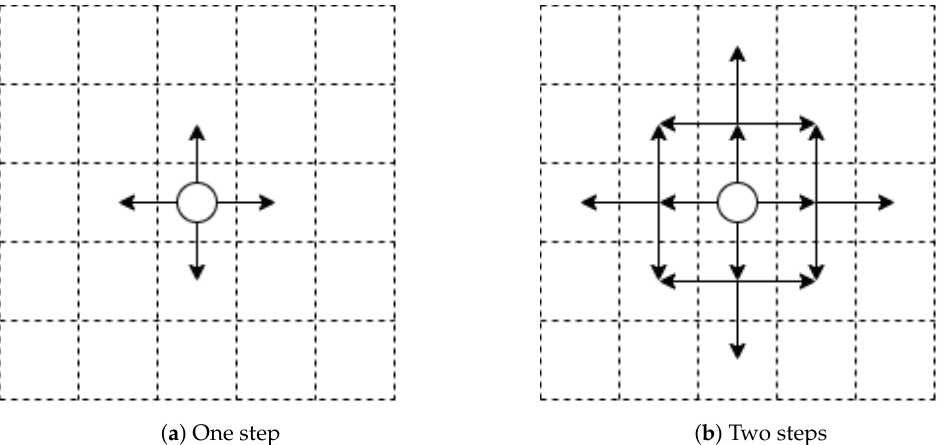
Figure 4. Heat diffusion to adjacent